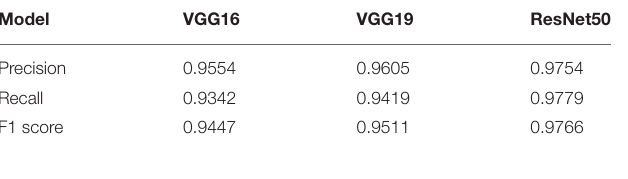
TABLE 8 | Performance metrics for the classification models using the evaluation dataset ( N = 3,172).